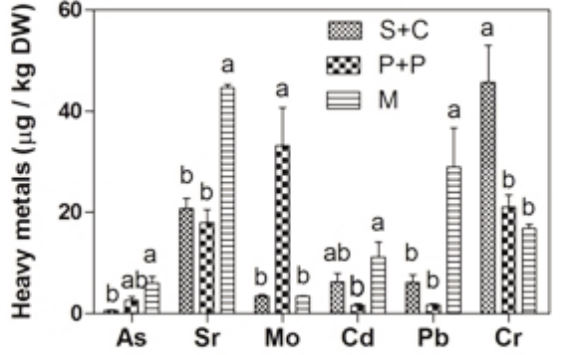
Fig. 4 - Heavy metals expressed as µg/kg DW determined in tomato fruits harvested from plants grown in sand and coir (S+C), peat+perlite (P+P) or purchased from the local market (M). Values are means with standard errors. Data were subjected to two-way AN OVA analysis and differences among means were determined using Bonferroni’ s post-test. Different letters indicate statisti- cal differences for